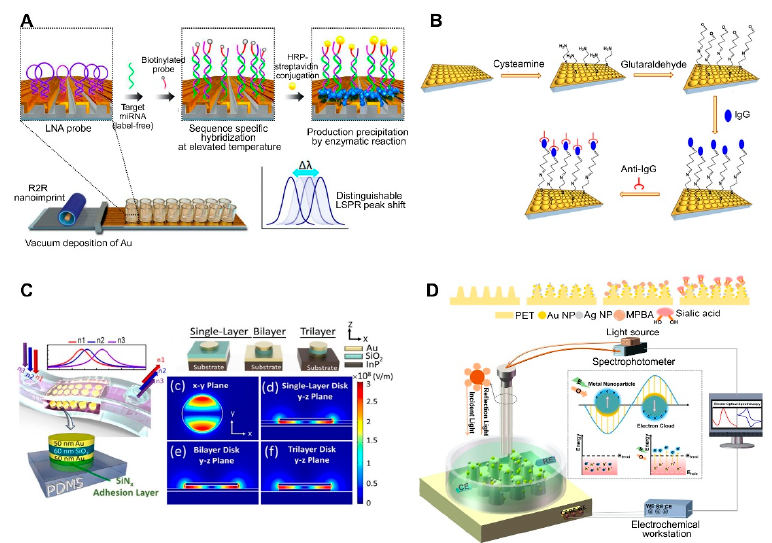
Figure 3. LSPR biosensing strategies based on nanopatterned structures: ( A ) Detection of miRNA using an inverted ‘L’-shaped nanostructure with nanograting pattern substrates functionalized with locked nucleic acids (LNAs). Reproduced with permission from [54]; ( B ) Detection of human IgG using a polystyrene (PS) sphere-deposited glass slide functionalized with antibodies, in which the use of PS of different sizes or shapes results in diverse cup substrates, enabling the modulation of plasmonic response. Reproduced with permission from [50]; ( C ) Detection of cancer cells attached to a metal–insulator–metal (MIM) integrative PDMS substrate. Reproduced with permission from [51]; ( D ) Detection of sialic acid by capturing with mercaptophenyl boronic acid (MPBA) via metal-S bond on nanocone shaped polyethylene terephthalate (PET) nanostructures densely covered with Au and AgNPs. Reproduced with permission from [67]. R2R, roll-to-roll; HRP, horseradish